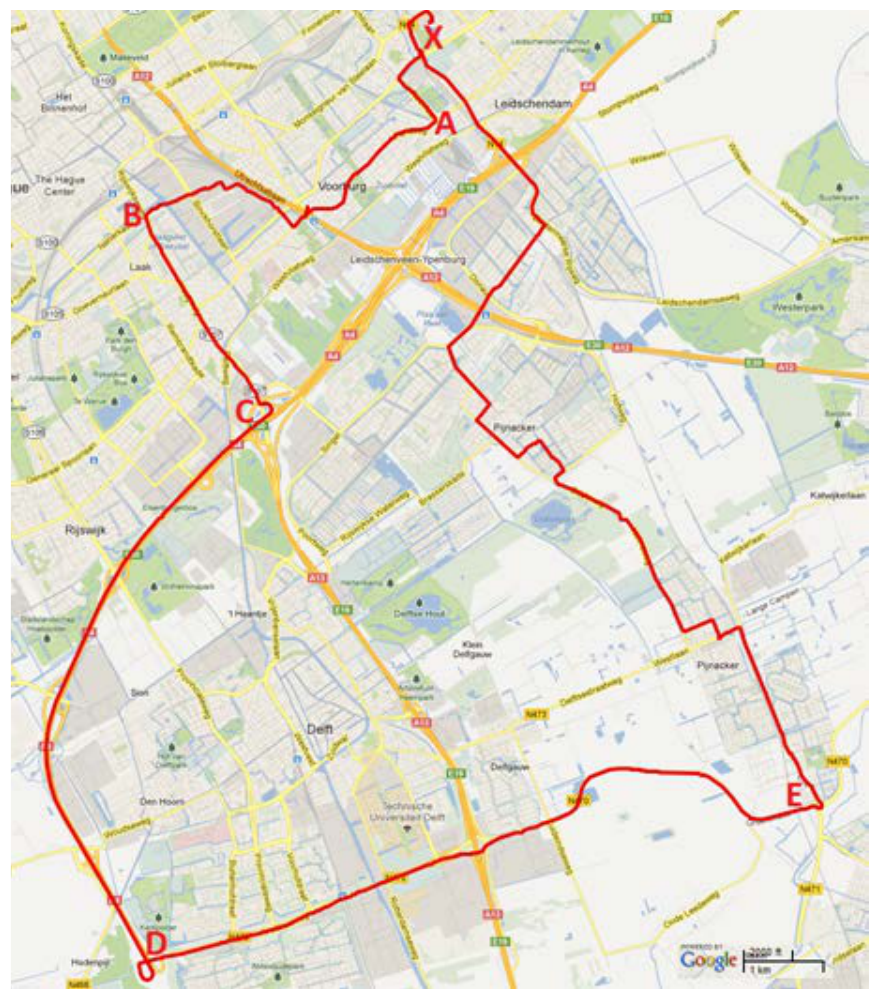
Figure 2. Route (© Google Maps), normally starting in X, in the The Hague